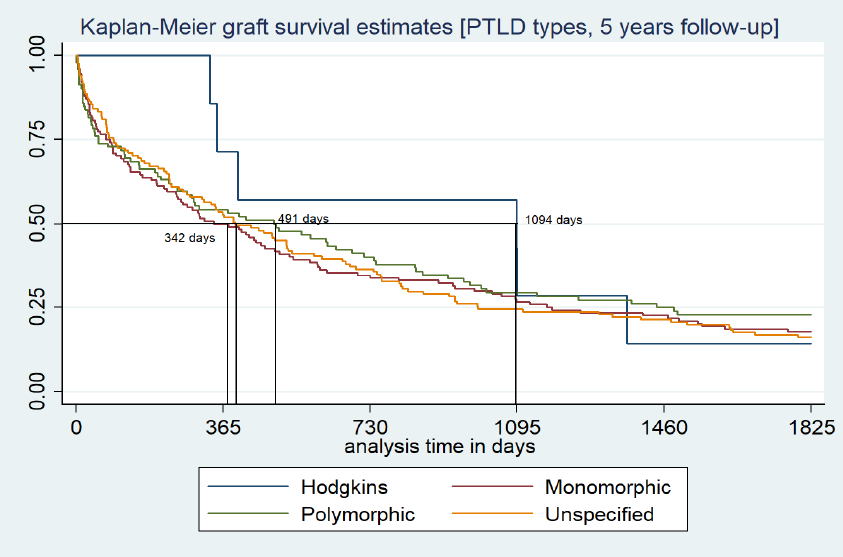
Figure 4. KM curve graft survival estimates among different types of PTLD.